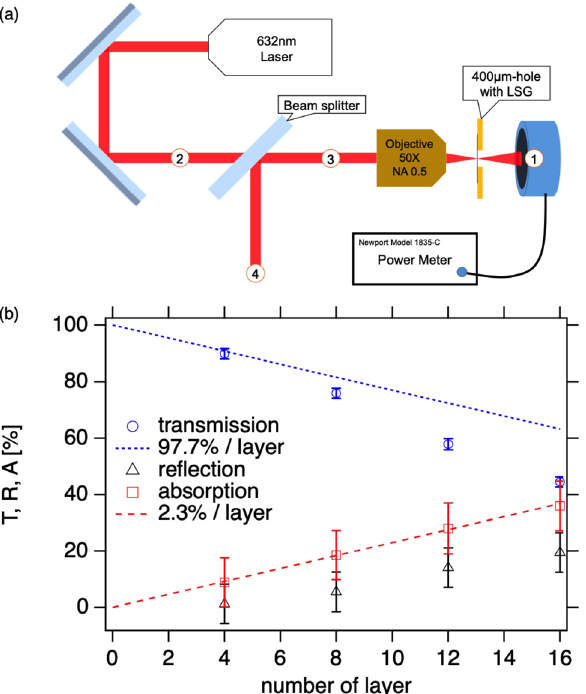
Figure 6. Off-line experiment: transmission and absorption. ( a ) Schematic image of setup for the LSG transmission/reflection measurement. ( b ) The transmission ( T ), reflection ( R ), and absorption rates ( A ) are plotted against the number of layer of LSG. The error bars represent the standard deviation of the measurements. The dotted lines represent the theoretical transmission (blue) and absorption rates (red) 26